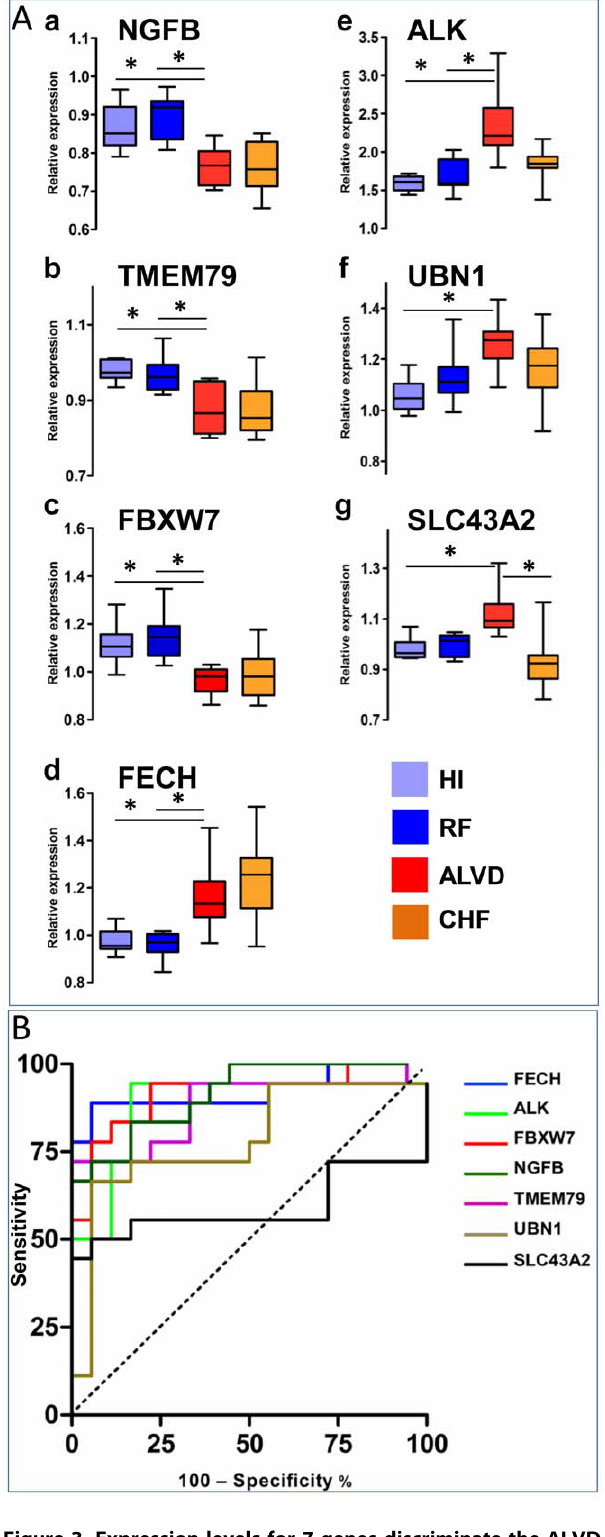
Figure 3. Expression levels for 7 genes discriminate the ALVD group. A. a–g Relative expression levels of the 7 genes, sorted by the nearest centroid classifier, are assessed for HI (light blue), RF (dark blue), ALVD (red) and CHF (orange) groups. The relative expression level used is defined by the ratio obtained with the tested sample to the signal obtained using the common reference, an equimolar mix of all the RNA